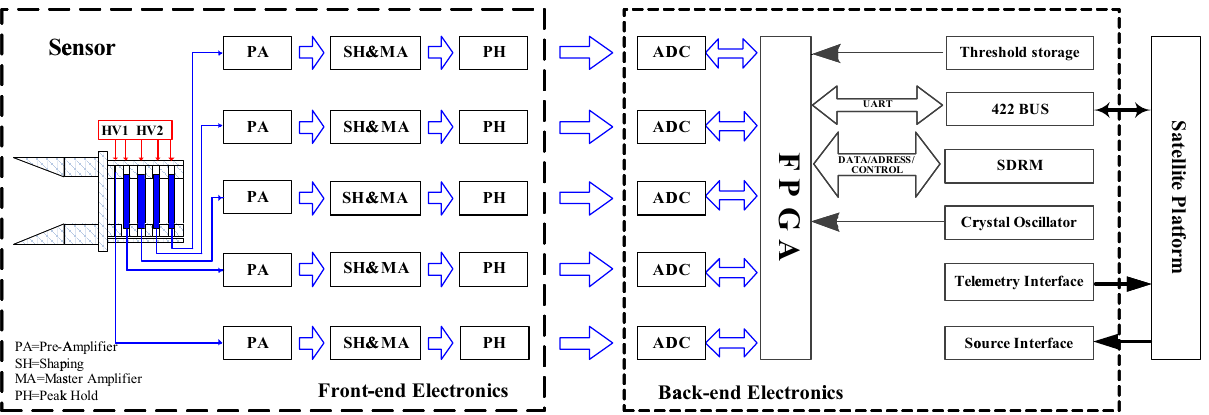
Figure 5: Block diagram of the instrument electronics.